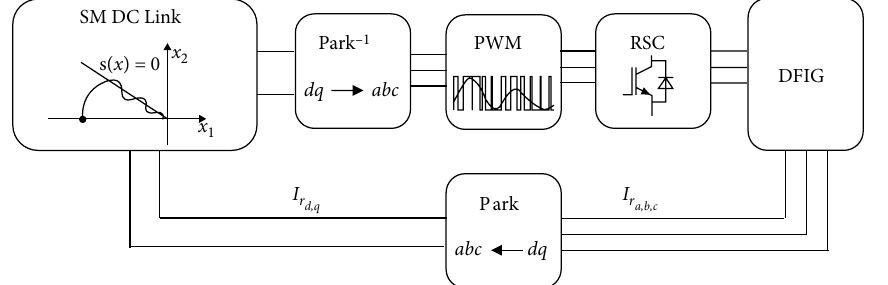
Figure 6: Control scheme of the RSC using the SM controller.